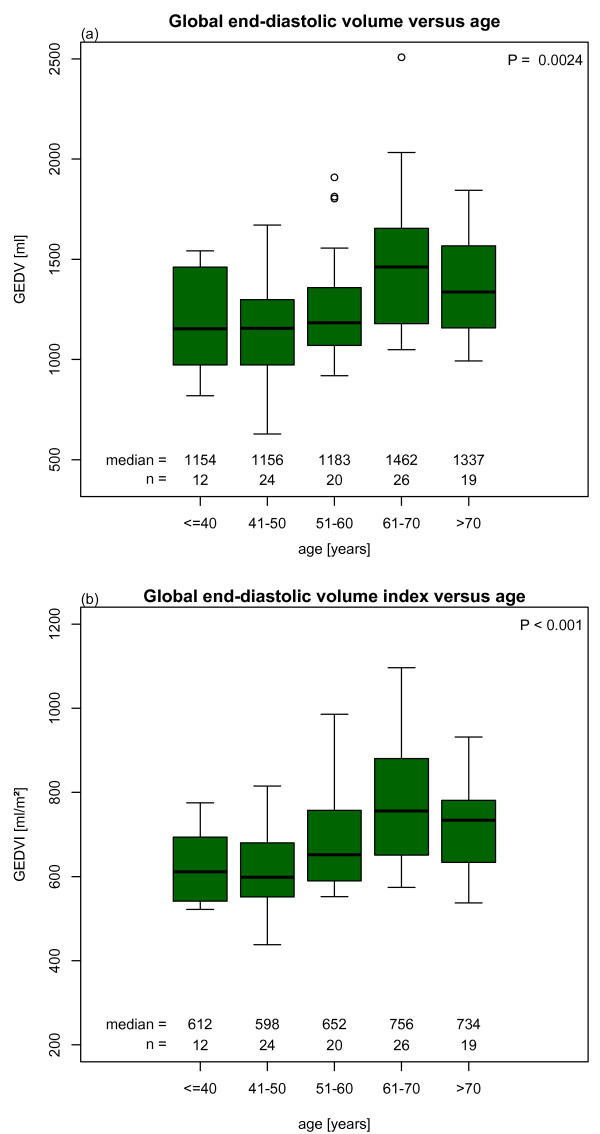
(a) Global end-diastolic volume (GEDV) and (b) global end-diastolic volume index (GEDVI) versus age in predefined groups (univariate comparison).